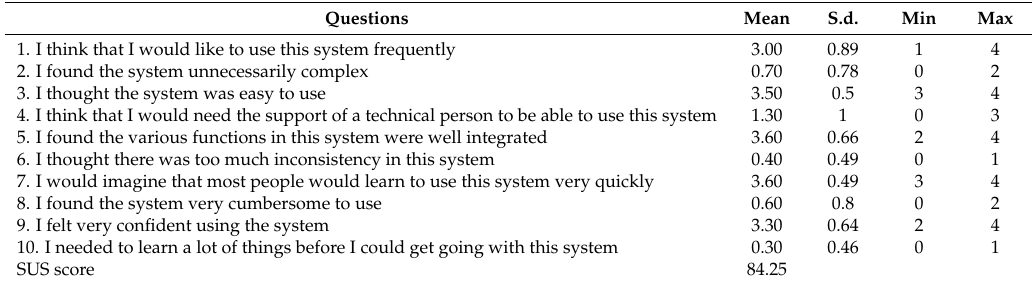
Table 2. Results of the SUS questionnaire (mean, standard deviation, minimum, and maximum).